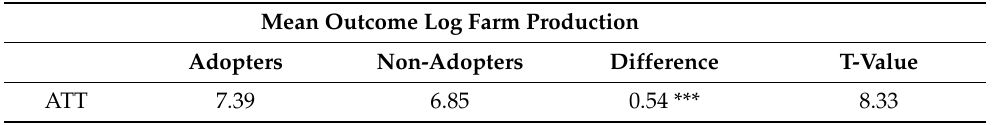
Table 3. Impact of ISFM adoption on log farm